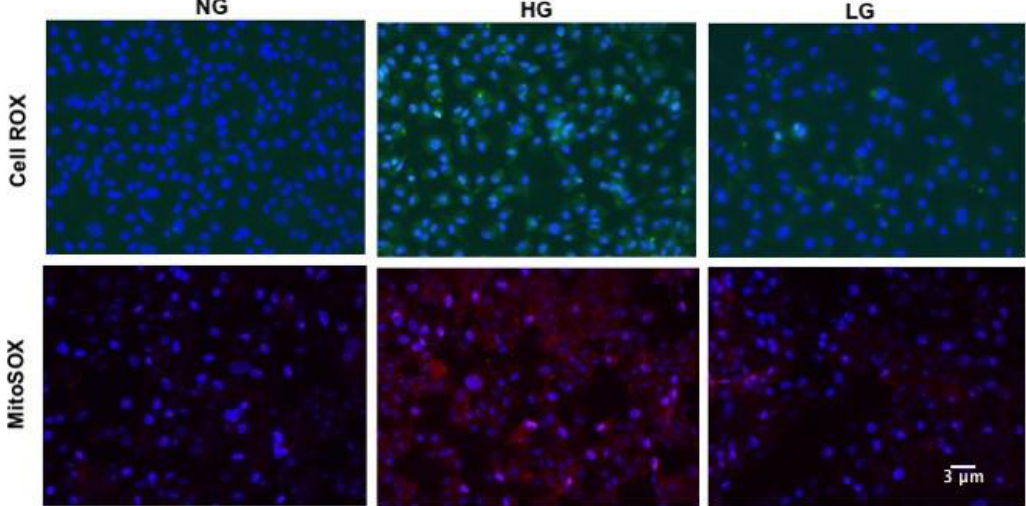
Figure 2. E ff ects of high glucose on cellular and mitochondrial reactive oxygen species (ROS). Upper panels: Micro images of CellROX-stained cells showing cellular ROS formation (green florescence) in HuREC treated for 48 h with high glucose (HG; 25 mM d -glucose), normal glucose (NG; 5 mM d -glucose), and the osmotic control L-glucose (LG; 25 mM l -glucose). Lower panels: Micro images of MitoSOX stained cells showing mitochondrial ROS formation (red florescence) in HuREC treated for 48 h with high glucose (HG; 25 mM d -glucose), normal glucose (NG; 5 mM d -glucose), and the osmotic control L-glucose (LG; 25 mM l -glucose). DAPI was used for nuclear counterstain (blue fluorescence).